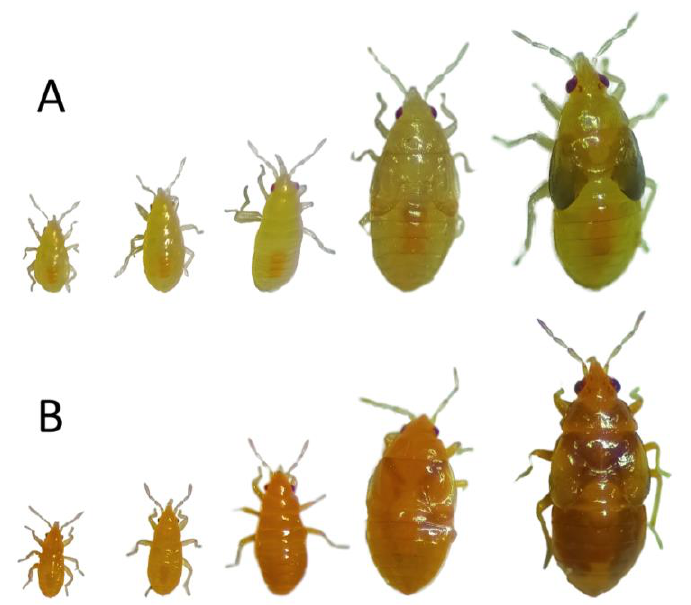
Figure 1. First to fifth instar nymphs of the normal ( A ) and mutant orange ( B ) populations of Orius laevigatus.